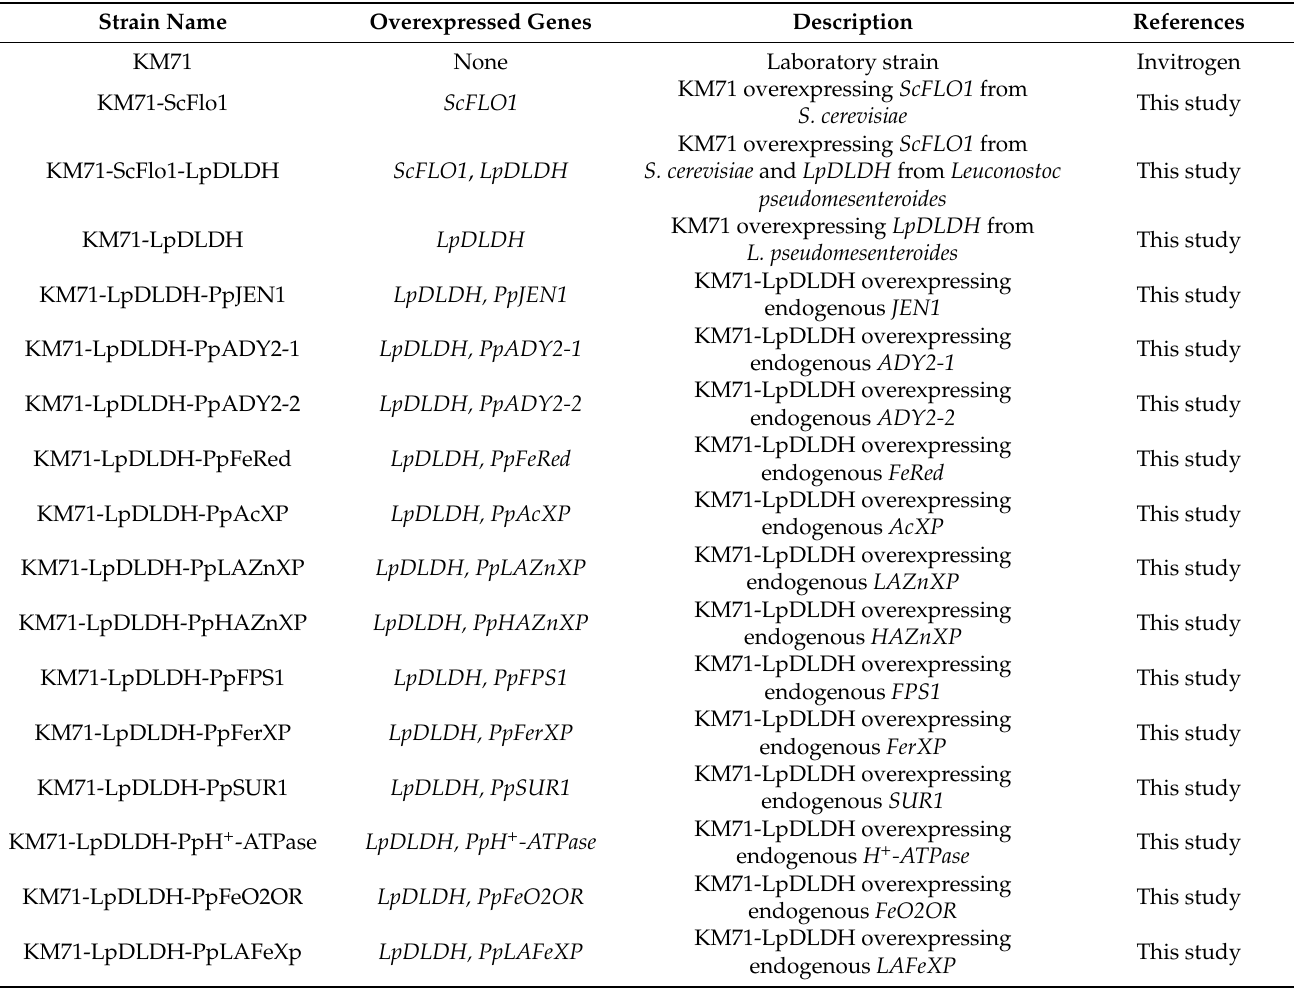
Table 1. Engineered strains generated in this